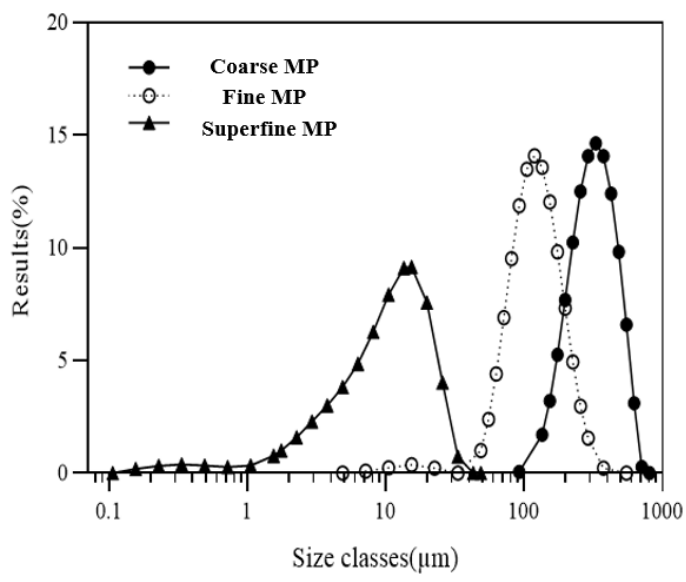
Figure 1. Particle size distribution of differently sized MP. Course MP: marigold course powder. Fine MP: marigold fine powder. Superfine MP: marigold superfine powder.